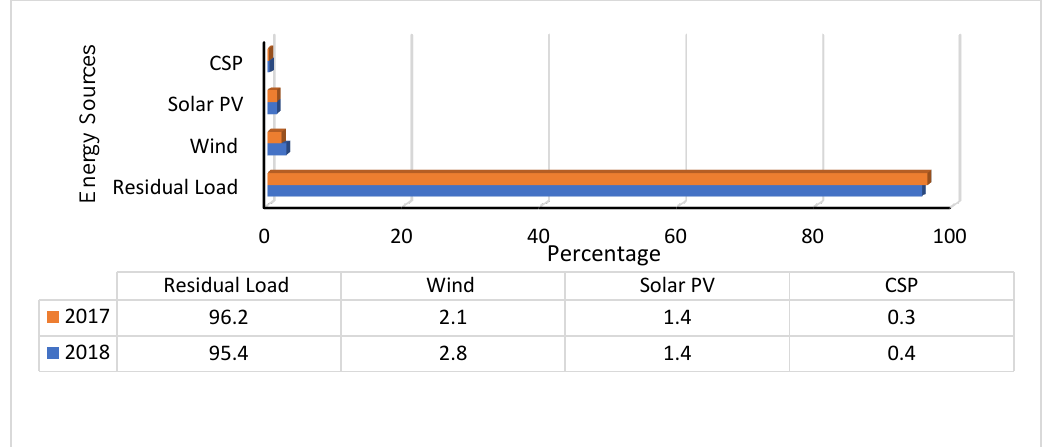
Figure 2. The percentage occupied by CSP, Solar PV, and Wind energy resource in 2017 and 2018 [20].